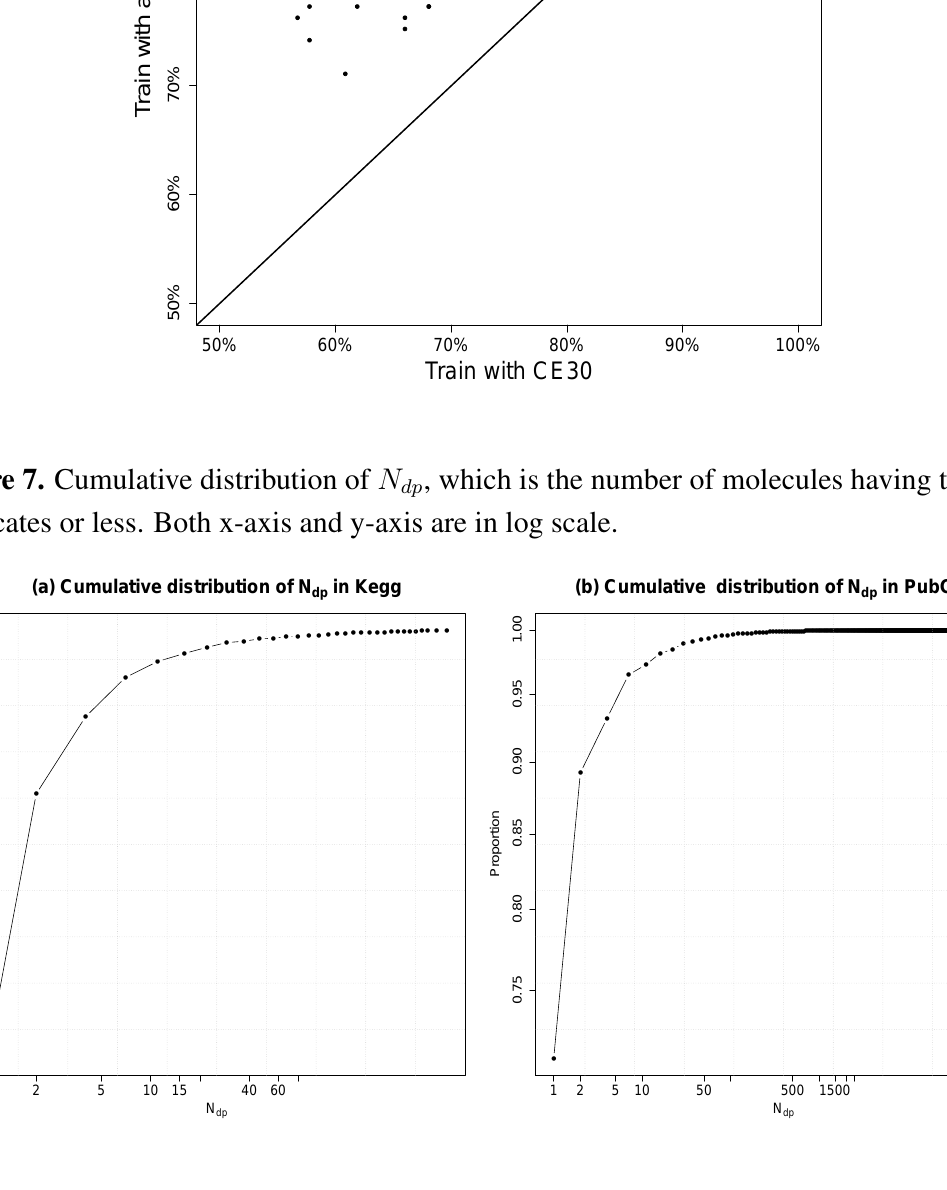
Figure 6. Fingerprint prediction accuracy on QqQ data with single collision energy data versus mixed collision energy data. The x-axis shows the accuracies of training model only using collision energy 30 eV and the y-axis shows the accuracies of training model using all available collision energies.